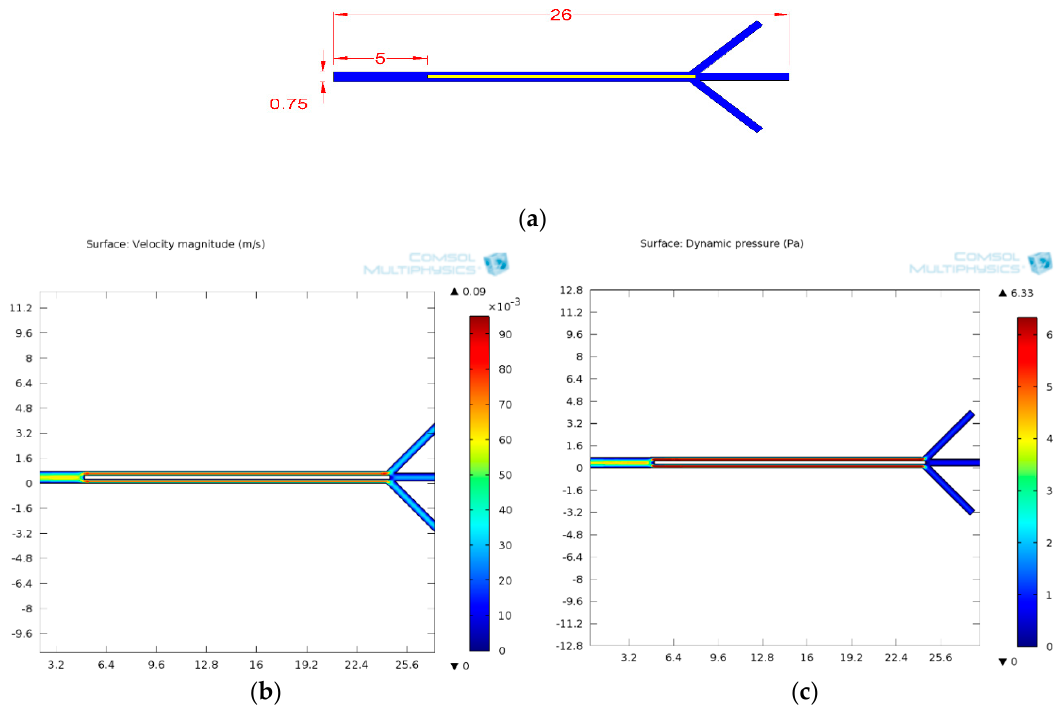
Figure 9. ( a ) The updated design for our proposed MAP stage and its surface plot of ( b ) velocity field and ( c ) fluid dynamic pressure. and ( c ) fluid dynamic